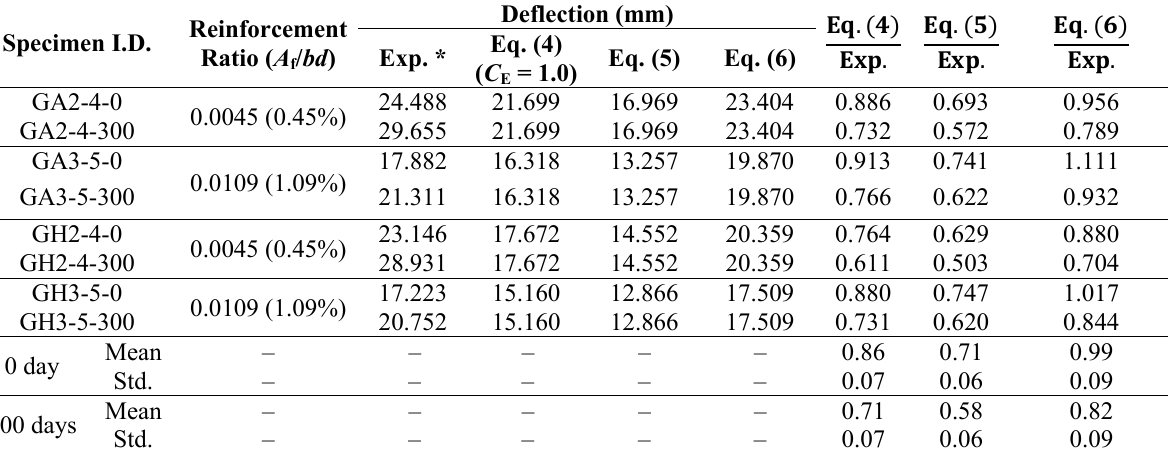
Table 4. Deflections at the ultimate